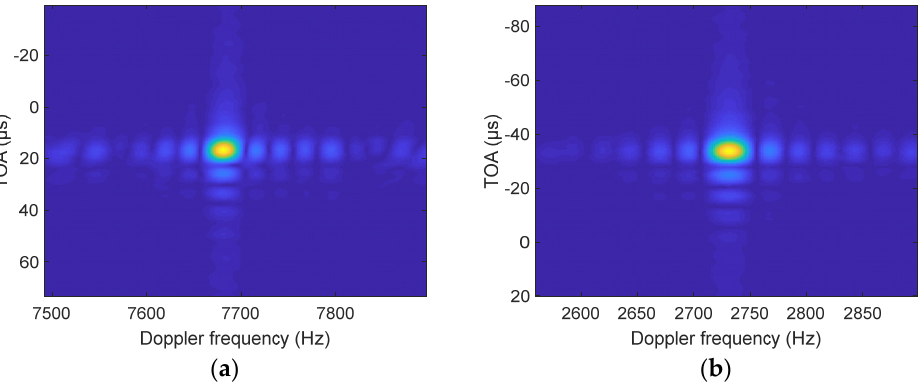
Figure 15. Two-dimensional compression result. ( a ) Receiver #1, ( b ) Receiver #2.